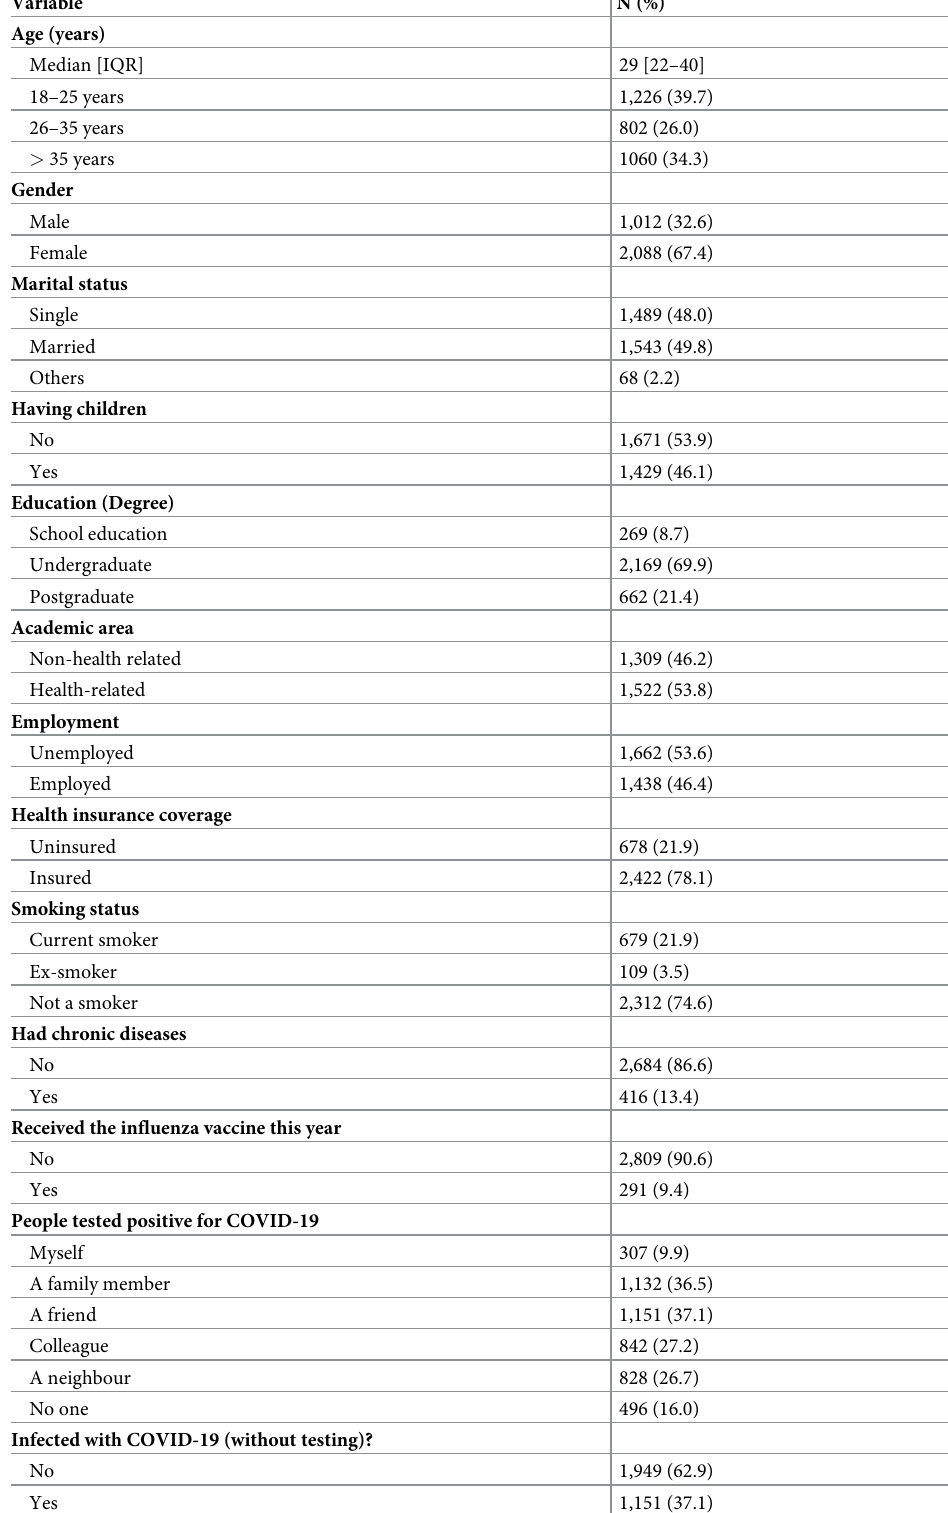
Table 1. Demographic details of study participants (n =